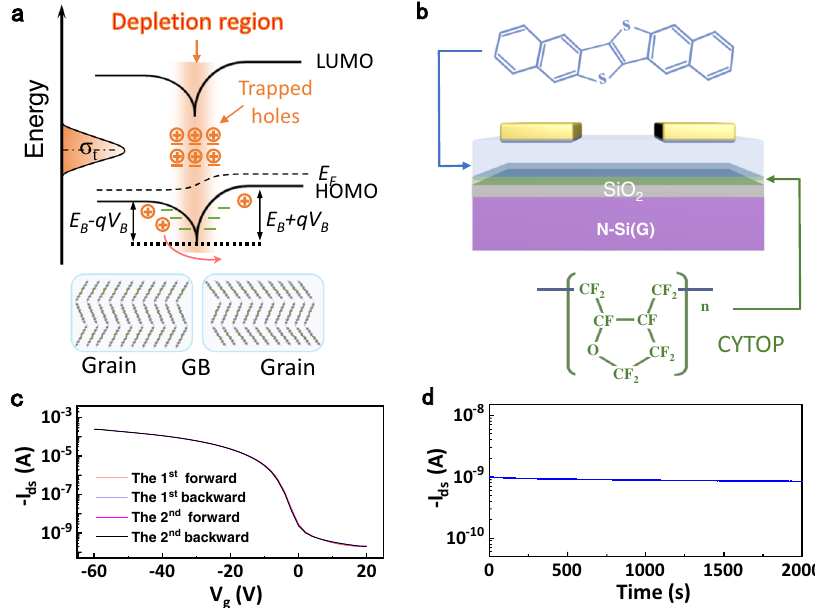
Fig. 1 Energy band diagram, OFET structure and operational stability data. a Schematic diagrams of energy band model at grain boundary (GB) of polycrystalline semiconductor with a bias voltage. b Schematic illustration of OFET and molecular structure of DNTT and CYTOP. c OFET transfer curves during the two cycle tests. V ds = − 60 V. d Bias stress curve of the OFET. V gs = 0 V, and V ds = − 60 V. The data in ( c , d ) denote the excellent operational stability of DNTT